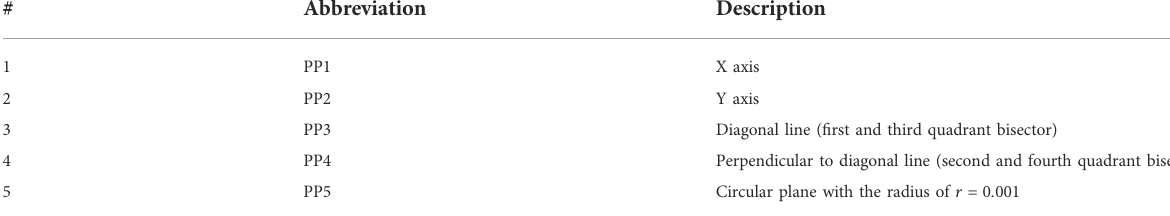
TABLE 1 Poincare planes used in this study.